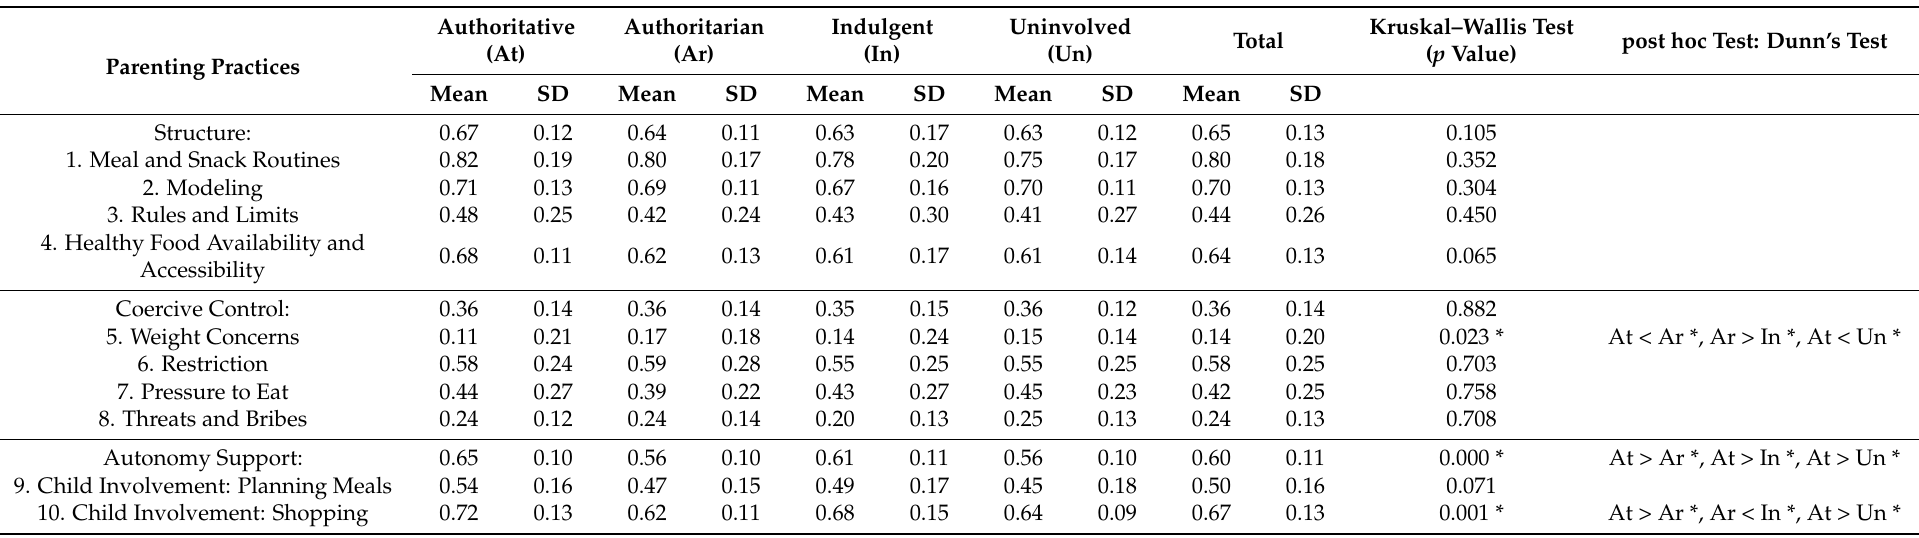
Table 2. Summary of food parenting practices by four parenting styles ( n =